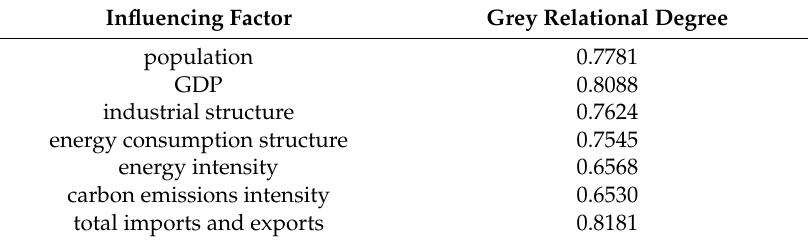
Table 1. The calculation results of the grey relational degrees for influencing factors.